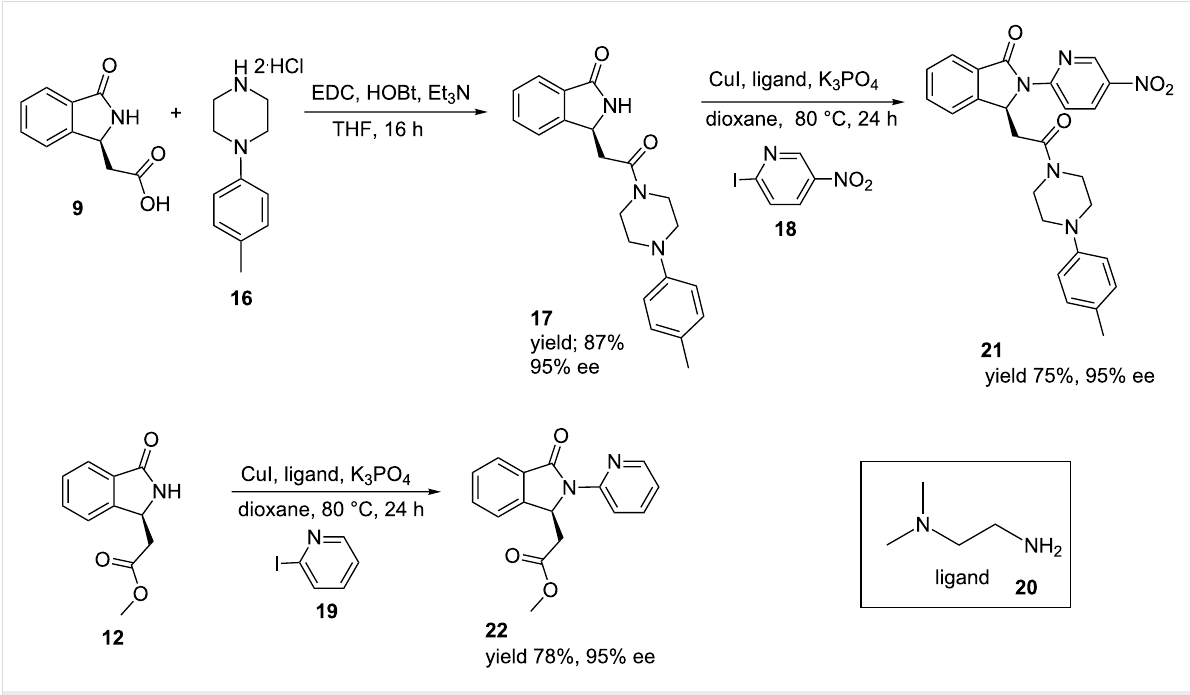
Scheme 5: Coupling of chiral acid 9 with p -tolylpiperazine and CuI arylation of chiral